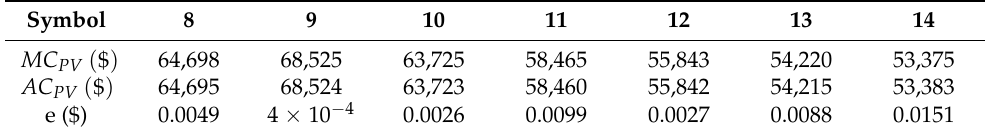
Table 5. The estimated error between 8 and 14 h.